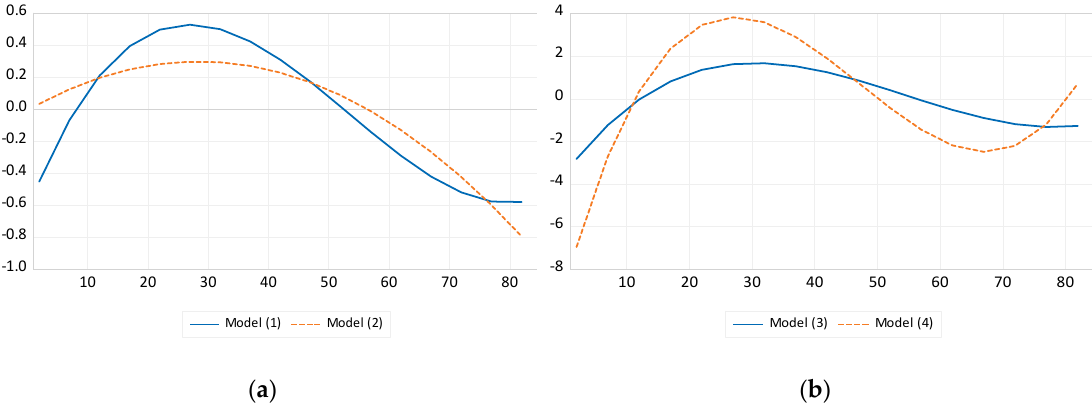
Figure 3. Comparison of age effect: Models (1)–(4). Note: x -axis represents the age and y -axis represents the normalized effect. ( a ) model (1) includes all the determinants of GHG emissions from road transportation; model (2) excludes the variable of polynomial structure. ( b ) model(3) excludes transport volume; model(4)uses only the factors related to personal transport use.